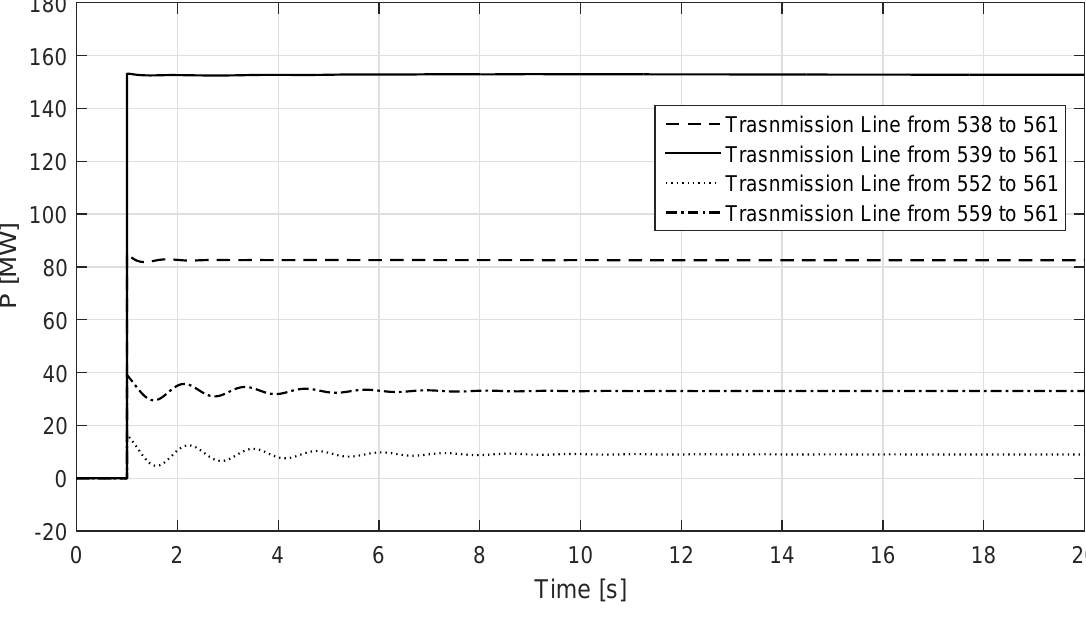
Figure 8. Transmitted active power through the connected transmission